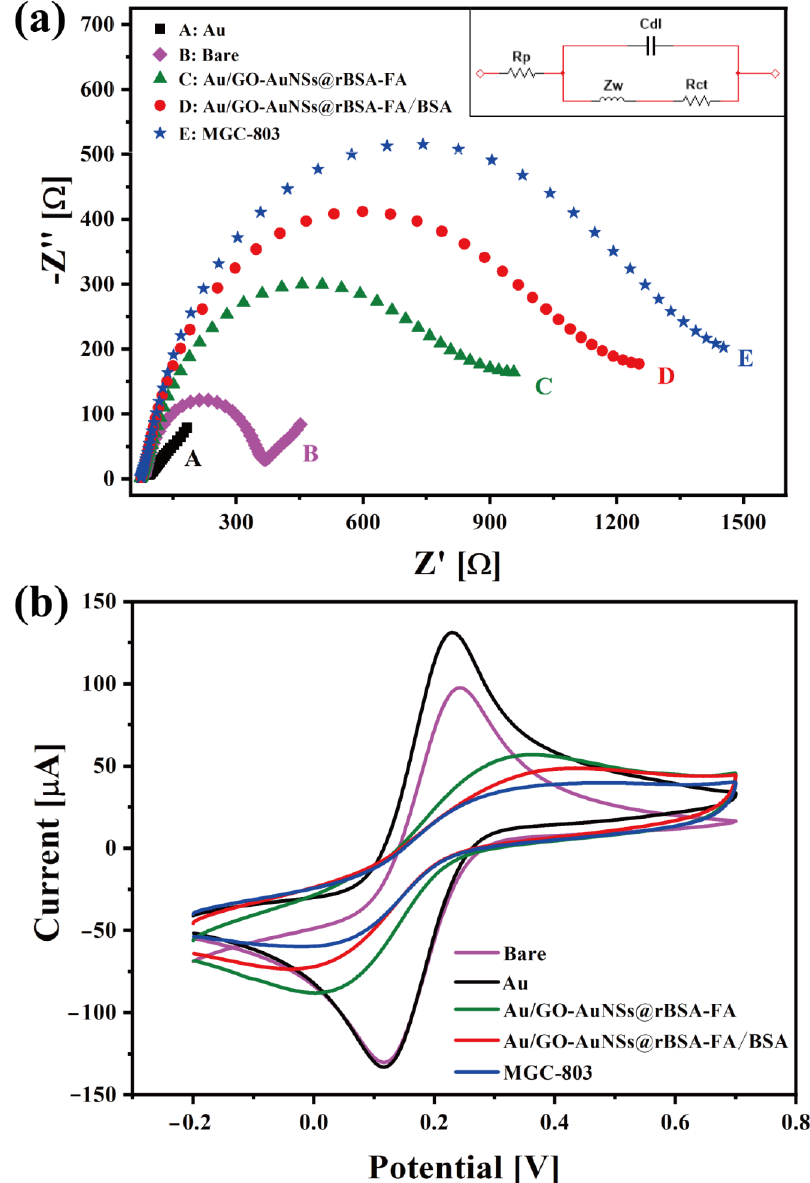
Figure 4. The ( a ) EIS graphs with an equivalent circuit inset in pictures a and ( b ) CV curves of different electrodes in various assembly steps. Among them, purple curves represent GCEs; black curves represent Au electrodes; green curves represent DpAu/GO-AuNSs@rBSA-FA electrodes; red curves represent DpAu/GO-AuNSs@rBSA-FA/BSAT electrodes; and blue curves represent DpAu/GO-AuNSs@rBSA-FA/BSAT electrodes modified with MGC-803 cells.